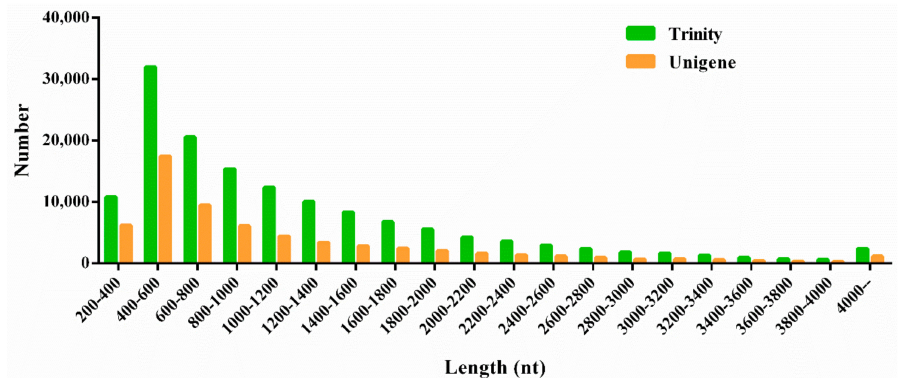
Figure 3. Pattern of length distribution of assembled trinities and unigenes.